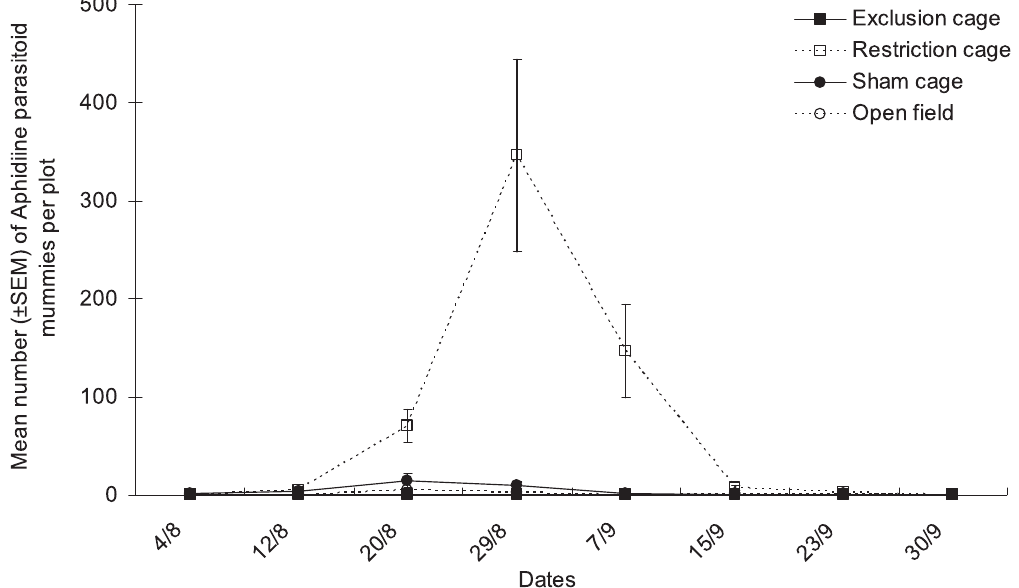
Figure 4. Population dynamics of aphid parasitoids. Mean numbers ( 6 SEM) of Aphidiine per plot in the various natural enemy exclusion treatments from early August to end of September in Bt cotton in Ezhou (China).